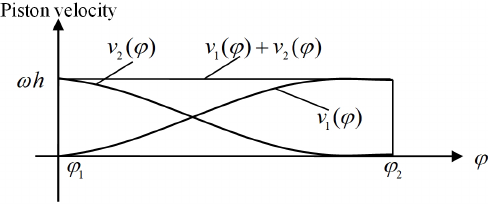
Figure 2. Piston velocities in transition processes. Figure 3. Transition